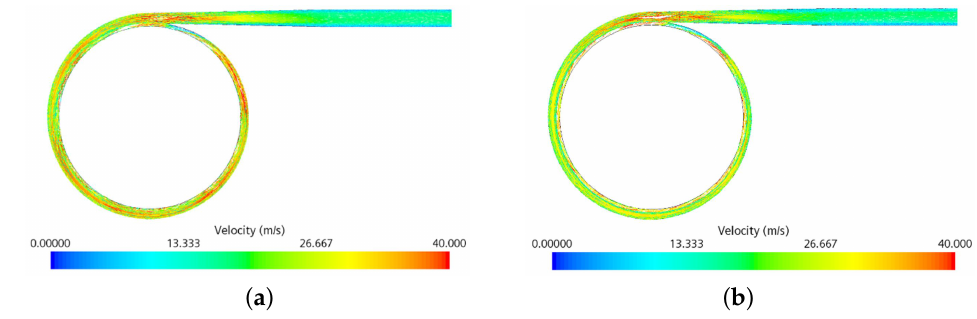
Figure 13. Volute velocity field: ( a ) proposed method; ( b ) Stepanoff